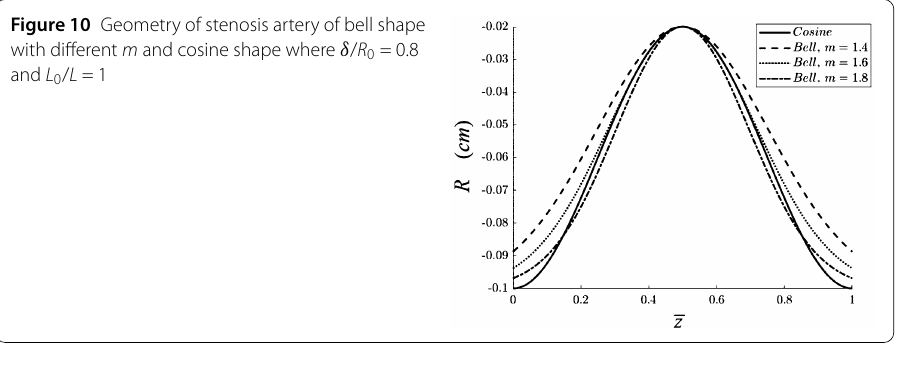
Figure 11 The comparison between bell shape with different m and cosine shape of axial velocity along radial axis at ¯ z = 0.5